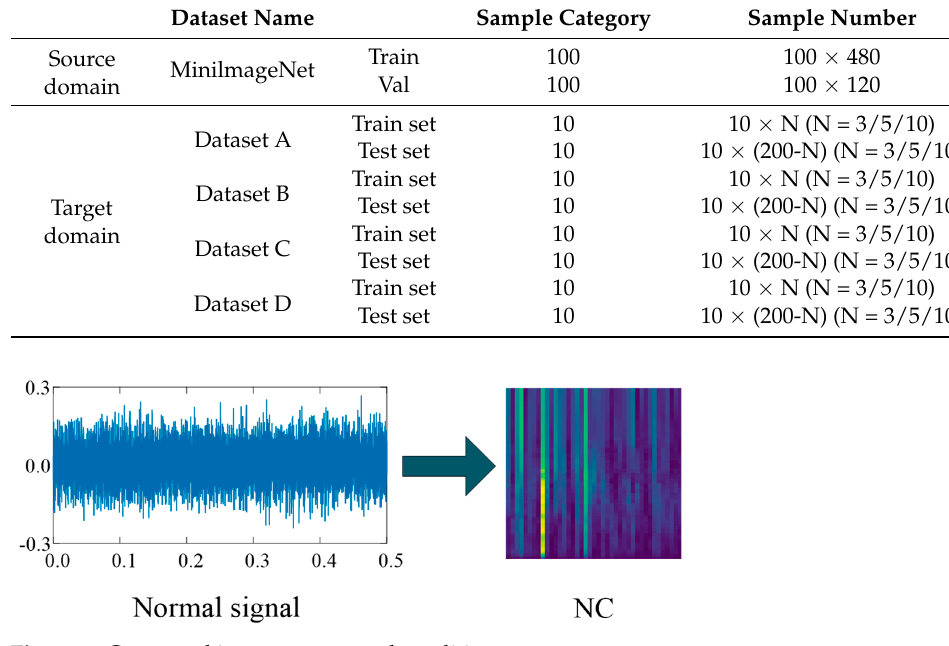
Figure 6. Converted images on normal conditions.